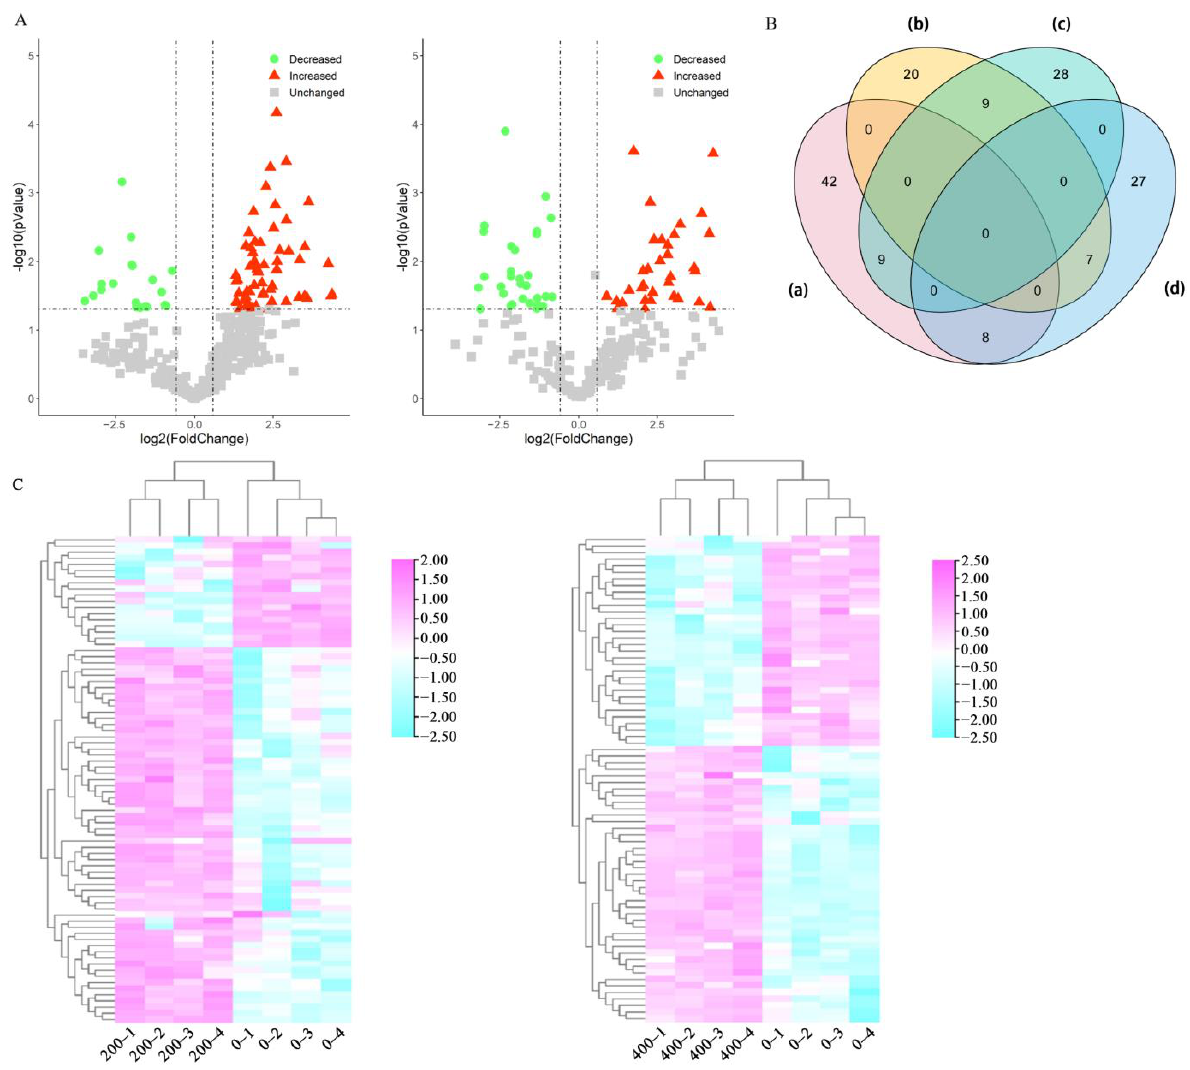
Figure 3. Quantitative analysis of the DEUPs. ( A ) Volcano plots of the DEUPs under 200 mM NaCl treatment ( left panel ) and 400 mM NaCl treatment ( right panel ). ( B ) Venn diagram of the DEUPs: ( a ) increased DEUPs under 200 mM NaCl treatment; ( b ) decreased DEUPs under 200 mM NaCl treatment; ( c ) increased DEUPs under 400 mM NaCl treatment; and ( d ) decreased DEUPs under 400 mM NaCl treatment. ( C ) Heat map of the hierarchical clustering of the DEUPs under 200 mM NaCl treatment ( left panel ) and 400 mM NaCl treatment ( right panel ). Table 1. Up/downregulated expression of ubiquitinated proteins in both the 200 mM and 400 mM NaCl treatment groups.